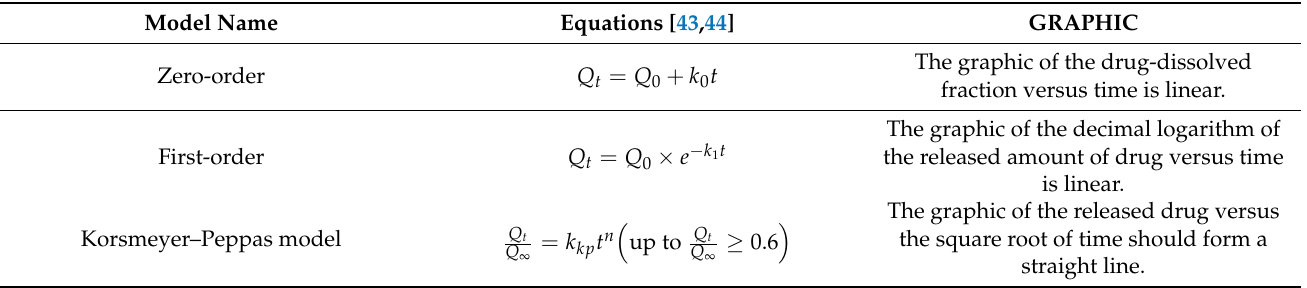
Table 2. Mathematical calculations of drug release